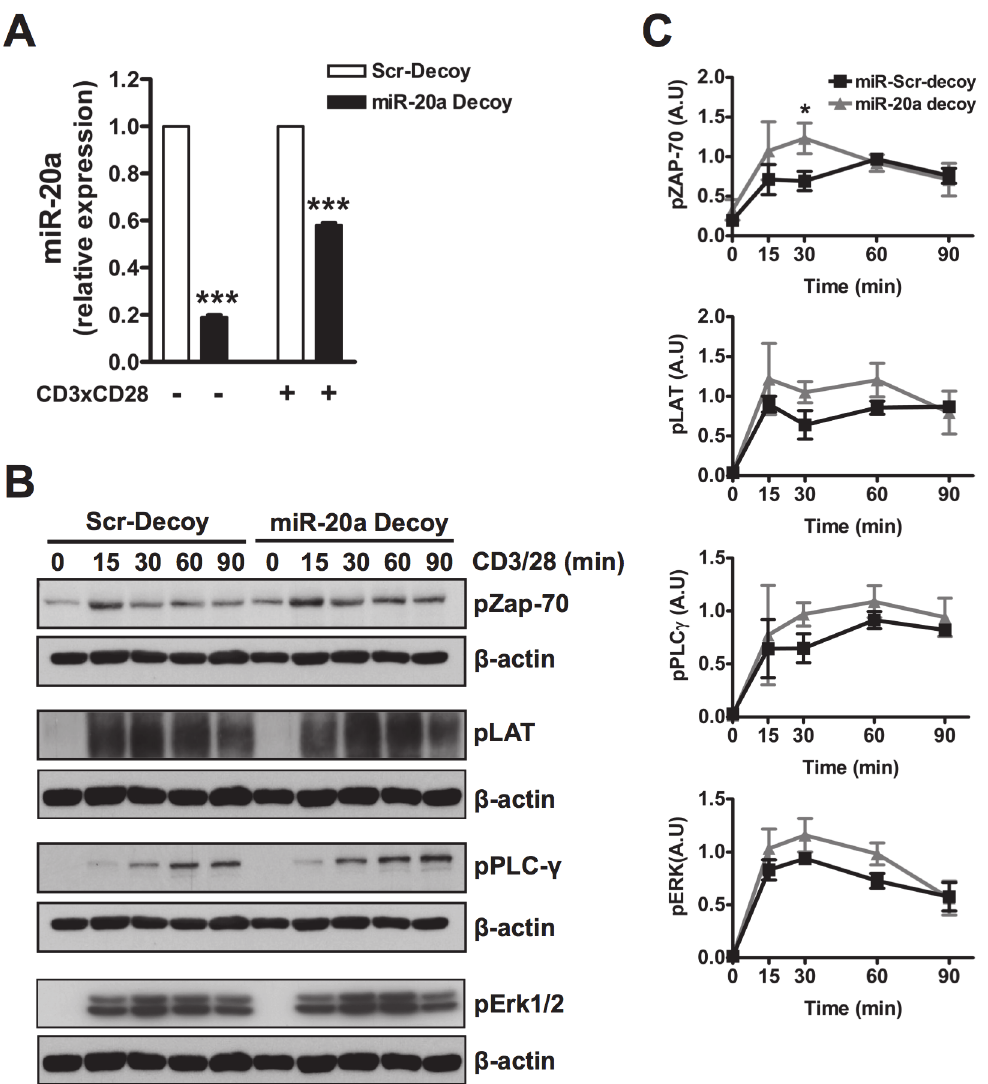
Fig 4. Inhibition of miR-20a slightly increases TCR-mediated signaling. Human na ï ve CD4 + T cells were transfected with miR-20a or scramble decoys. (A) Quantification of miR-20a expression in resting and in stimulated cells upon stimulation with plate-bound CD3 and CD28 mAbs for 45 min was performed using RT qPCR. (B) 16 hours after transfection, cells were stimulated with microbeads coated with CD3 and CD28 mAbs for the indicated time periods. Subsequently, lysates were analyzed by immunoblotting using the indicated Abs. Bands in (B) were quantified using the ImageQuant software and values were normalized to the corresponding β -actin signal. Graphs in (C) show the phosphorylation levels of the indicated molecules as arbitrary units ± SEM of 3 independent experiments. Significat P values were calculated by using Student ’ s t Test. ( * , P <